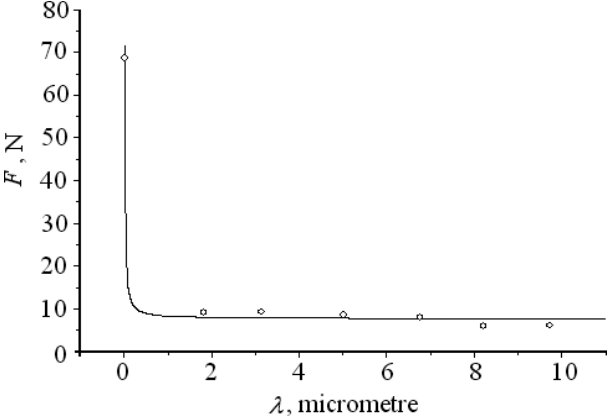
Fig. 4. Effect of ultrasonic vibration amplitude on cutting force. Comparison of calculations (solid line) and experimental data for turning of aluminium.